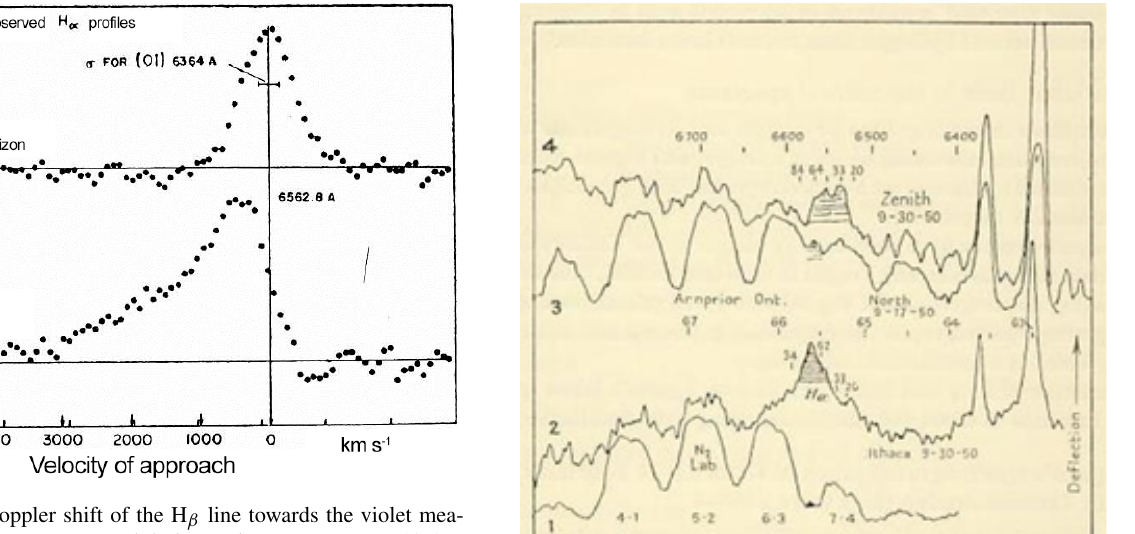
larger H α shifts towards the violet the greater the initiating proton’s